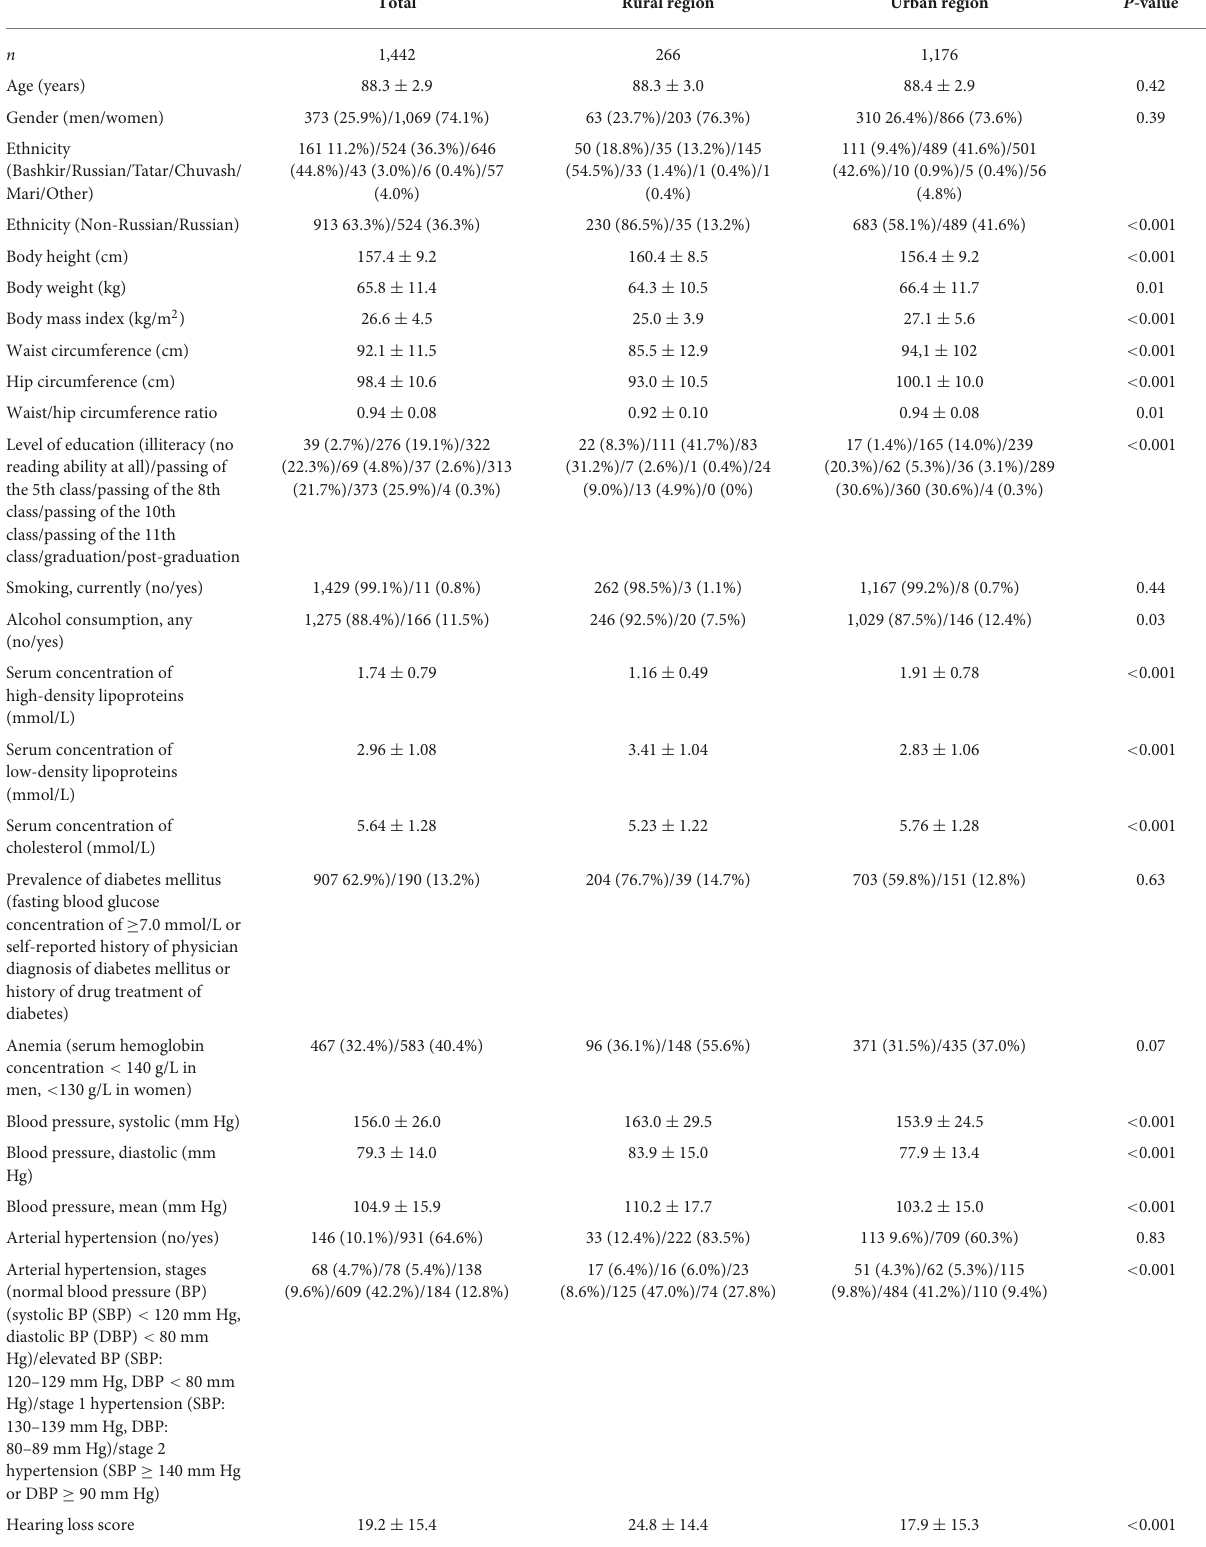
TABLE 1 Demographic, lifestyle-related, diet, physical activity-related, health assessment-related, and other parameters (mean ± standard deviation or numbers and percentage in brackets) in the Ural Very Old Study, stratified between the rural part and the urban